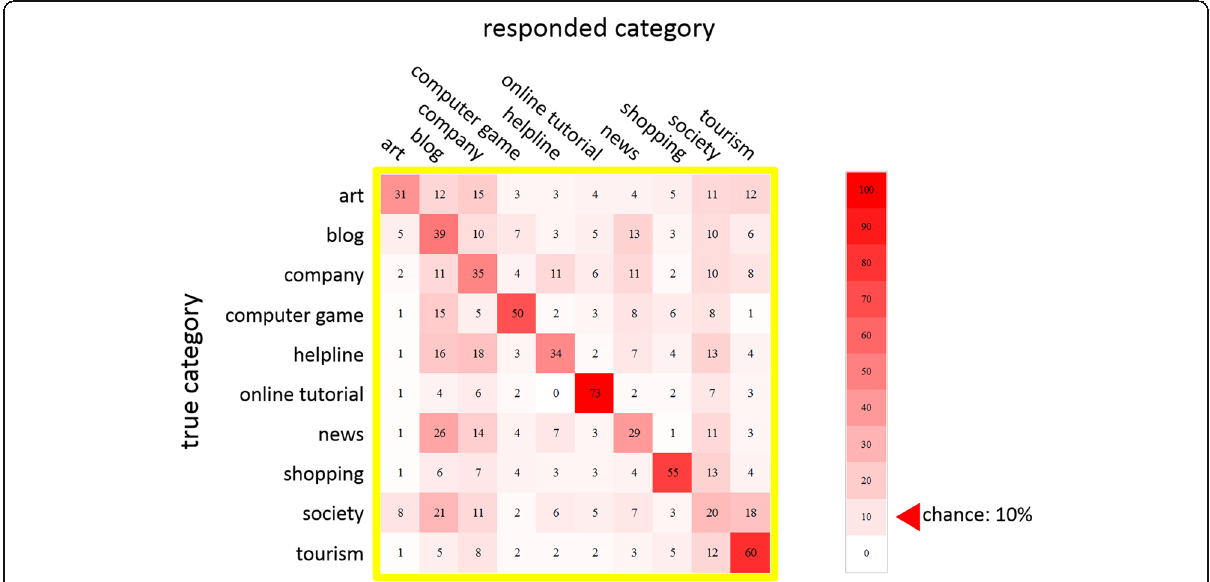
Fig. 6 Results of the gist experiment with scrambled text. As in the previous confusion matrix, the value in each cell is the percentage of trials for which, for each true category (row label), the screenshot was labeled as indicated by the column